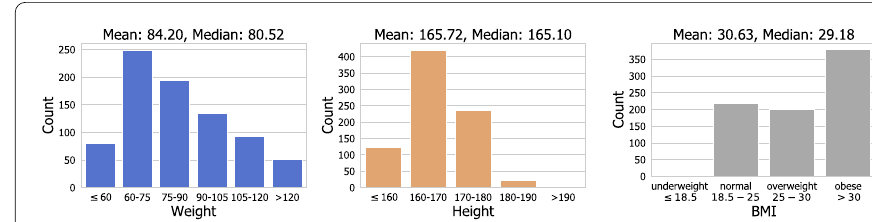
Figure 3 Female images in Reddit data (N = 800, 47.7% of all images)